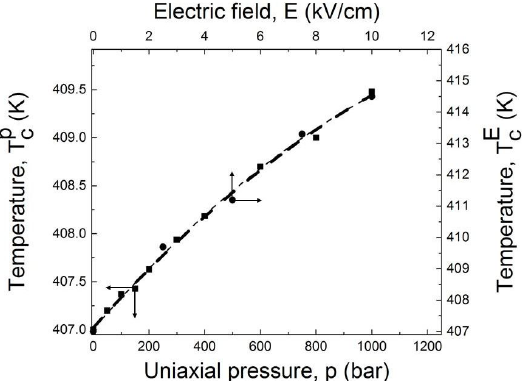
shifting in dependence on an uniaxial Figure 1. A complex plot of T c pressure, p , (filled squares, thick dash) and on an electric field, E , (filled circles, thin